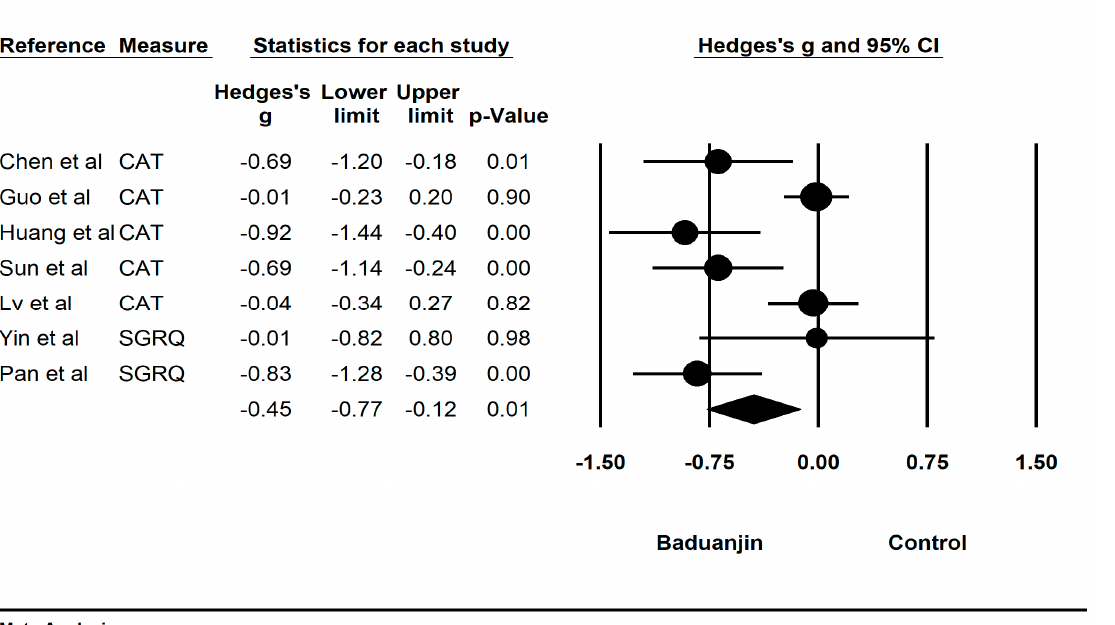
Figure 13. Effects of Baduanjin on quality of life of COPD patients.